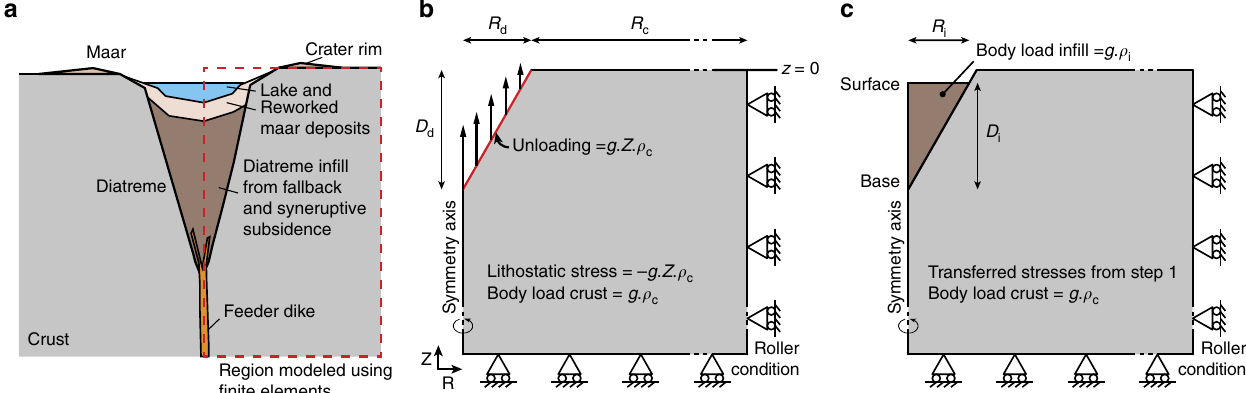
Fig. 1 Finite element model con fi guration. a Sketch of a maar – diatreme complex. Modi fi ed from Lorenz 33 . The dotted red square represents the area modeled numerically using an axisymmetric axis. b The initial step models the excavation stage. The model is gravitationally loaded with a lithostatic pre- stress and a body load. A vertical load acting on the diatreme ’ s wall represents the mass of rock excavated. c The second step models the in fi lling stage. The initial stress conditions and geometry are transferred from the initial step. The diatreme is fi lled with either 25, 50, or 75% of the total diatreme volume. Physical parameters are E c = 15 GPa, η c = 0.25, and ρ c = 2300 kg m − 3 for the crust, E i = 2.5 GPa, η i = 0.25, and ρ i = 2000kg m − 3 for the in fi